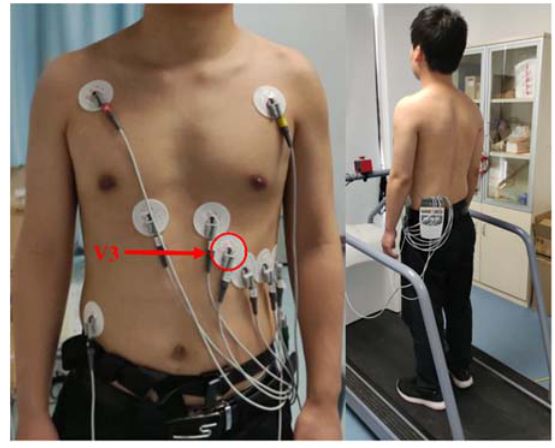
Figure 1. The scenario of the data collection experiment.